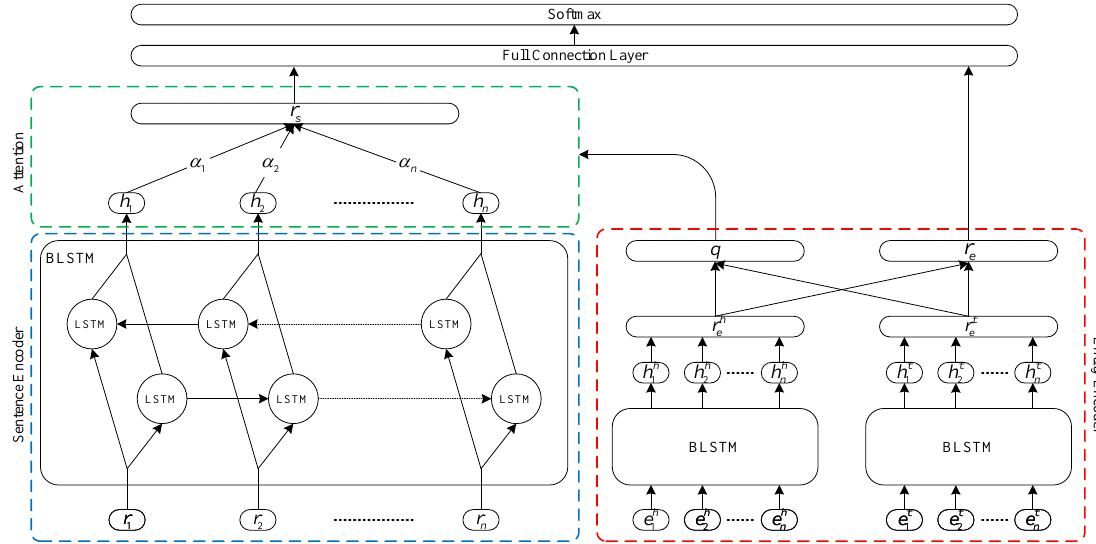
Figure 4. Proposed Attention-based model, r i represents the i -th input of the sentence, e h embedding of the i -th input of the head and tail entity. q and r e are calculated by the head entity r h e and tail entity r t e in different ways. The weight α i is calculated by q and h the hidden states using